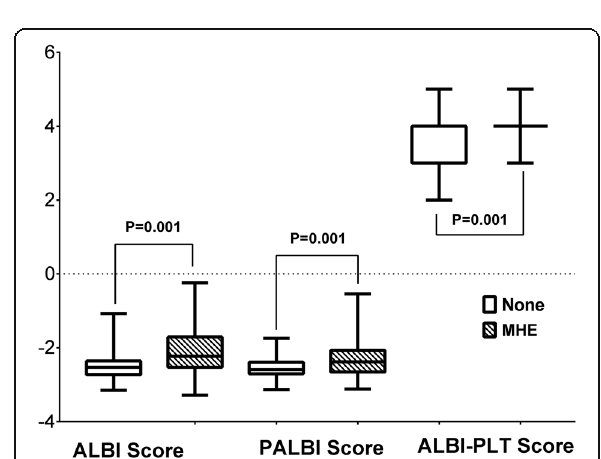
Fig. 1 Comparison of the ALBI, PALBI and ALBI-PLT in patients with and without MHE